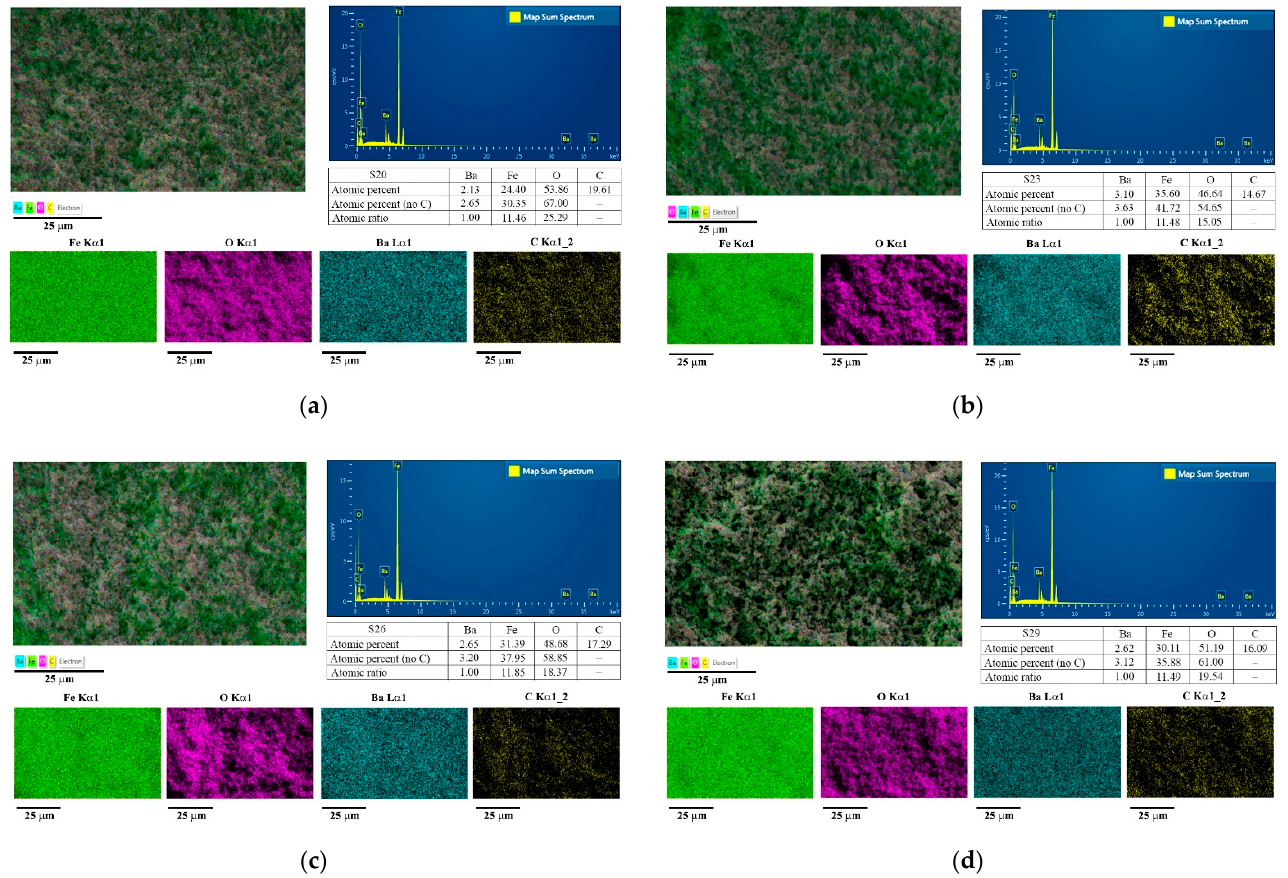
Figure 3. Elemental composition mapping of samples ( a ) S20, ( b ) S23, ( c ) S26, and ( d ) S29. The M-type BaFe 12 O 19 phase comparable to the literature [41] is confirmed in every sample by XRD spectra in Figure 4. The diffracted peaks from the crystallographic planes of (110), (107), (114), (203), (205), (217), (2011), (220), (2014), and (317) are at 30.31 ° , 32.20 ° , 34.11 ° , 37.08 ° , 55.06 ° , 56.60 ° , 63.06 ° , 67.36 ° , and 72.59 ° , respectively (JCPDS: 00-043-0002). Interestingly, the most intense peak in each spectrum is characterized as the metallic Fe at 43.50 ° from the (110) plane (JCPDS: 01-071-4650). The minor Fe peak at 63.20 ° , corresponding to the (200) plane, is also present near a minor BaFe 12 O 19 peak. The Fe peak intensities of three replicates (S18–S20, S21–S23, S24–S26, and S27–S29) vary substantially within each formulation. Nevertheless, the crystallite size, determined from the width of the major Fe peak using the Scherrer equation [42], is relatively constant. The average Fe crystallite sizes obtained from different formulations are comparable at 24 nm. This size is smaller than a twice domain wall thickness of hexaferrites; enabling the exchange coupling between hard and soft magnetic phases [34].